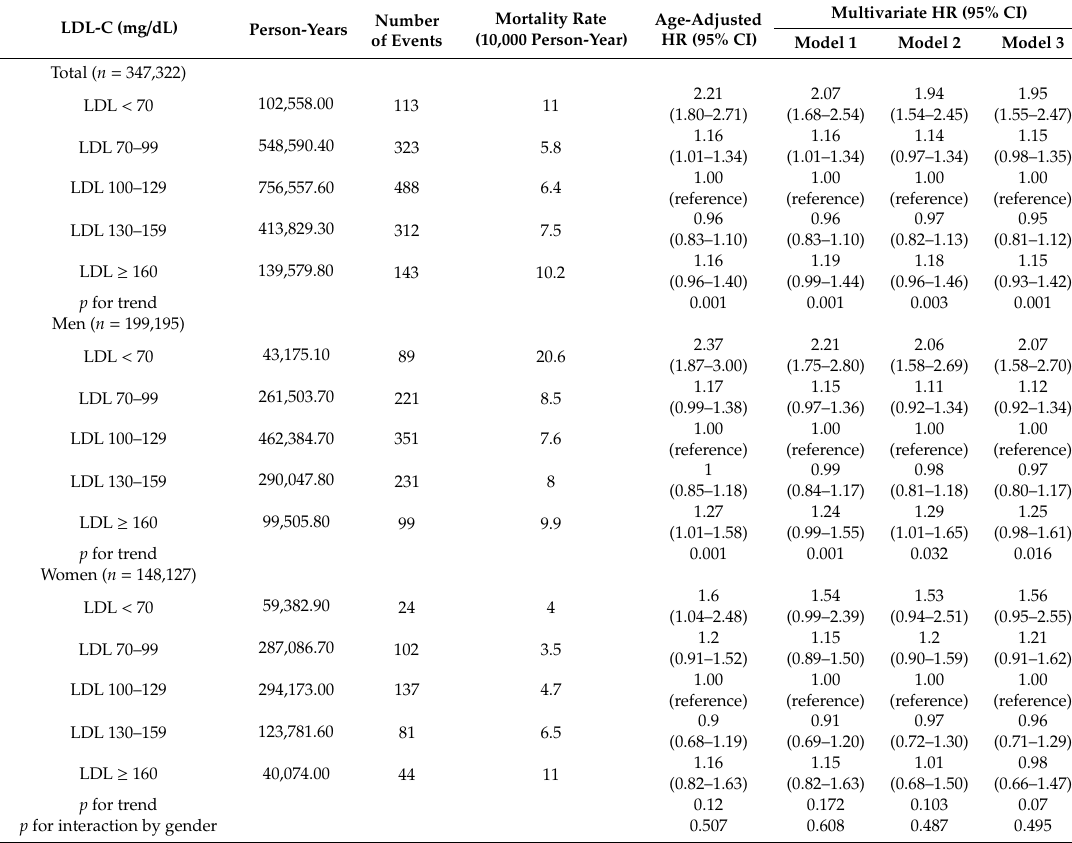
Table 2. Risk of all-cause mortality according to baseline LDL-C levels excluding subjects who died within 3 years of follow up in Kangbuk Samsung Health